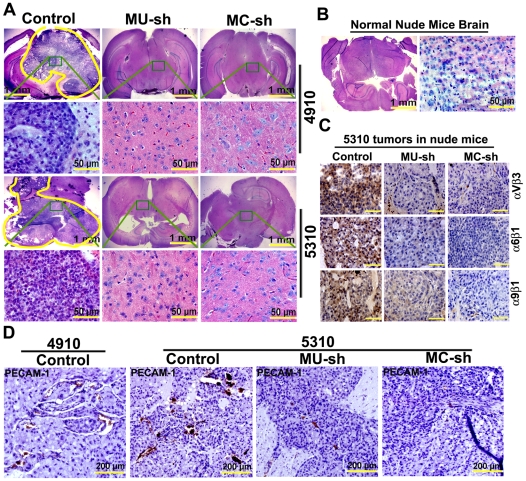
Effect of treatment with bicistronic constructs on the brain tumors in nude mice pre-injected with xenograft cells.(A) shRNA mediated regression of pre-established tumor growth. Hematoxylin and eosin staining performed on the brain sections obtained from various groups of animals revealed a prominent tumor reduction after MMP-9/uPAR (MU-sh) or MMP-9/cathepsin B (MC-sh) treatments. Each group consisted of 6 animals. Yellow curved line in 4910 and 5310 control brain sections indicate the tumor area. (B) Normal nude mice brain section stained with hematoxylin and eosin. (C) Immunohistochemical comparison of control, MU-sh and MC-sh-treated nude mice which are pre-injected with 5310 cells (and sacrificed 2–3 weeks prior to the end of the treatment), to analyze the expression of αVβ3, α6β1 and α9β1 integrin heterodimers. Brown staining indicative of αVβ3, α6β1 or α9β1 integrin expression was reduced in MU-sh and MC-sh treated sections compared to controls. n = 6. Scale bar = 50 µm. (D) Untreated 4910 and 5310 in vivo tumors were prominently stained for platelet endothelial cell adhesion molecule (PECAM-1) whereas the intensity of brown staining was reduced in 5310 in vivo tumors after MU-sh and MC-sh treatments.